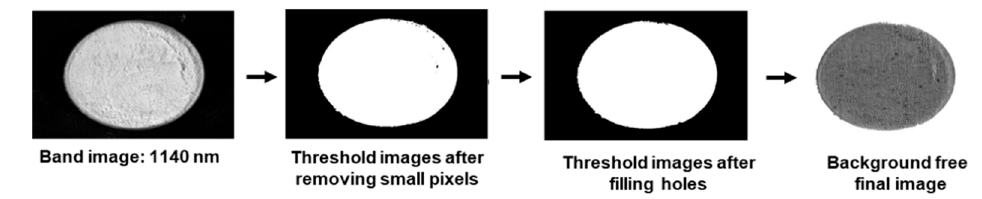
Figure 3. Preprocessing steps of hyperspectral image for discarding background area.